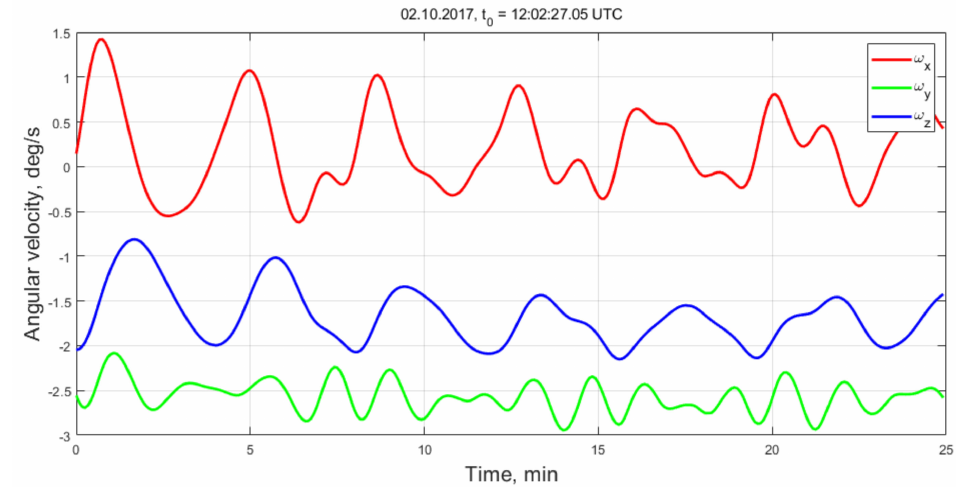
Figure 15. Estimated angular velocity.